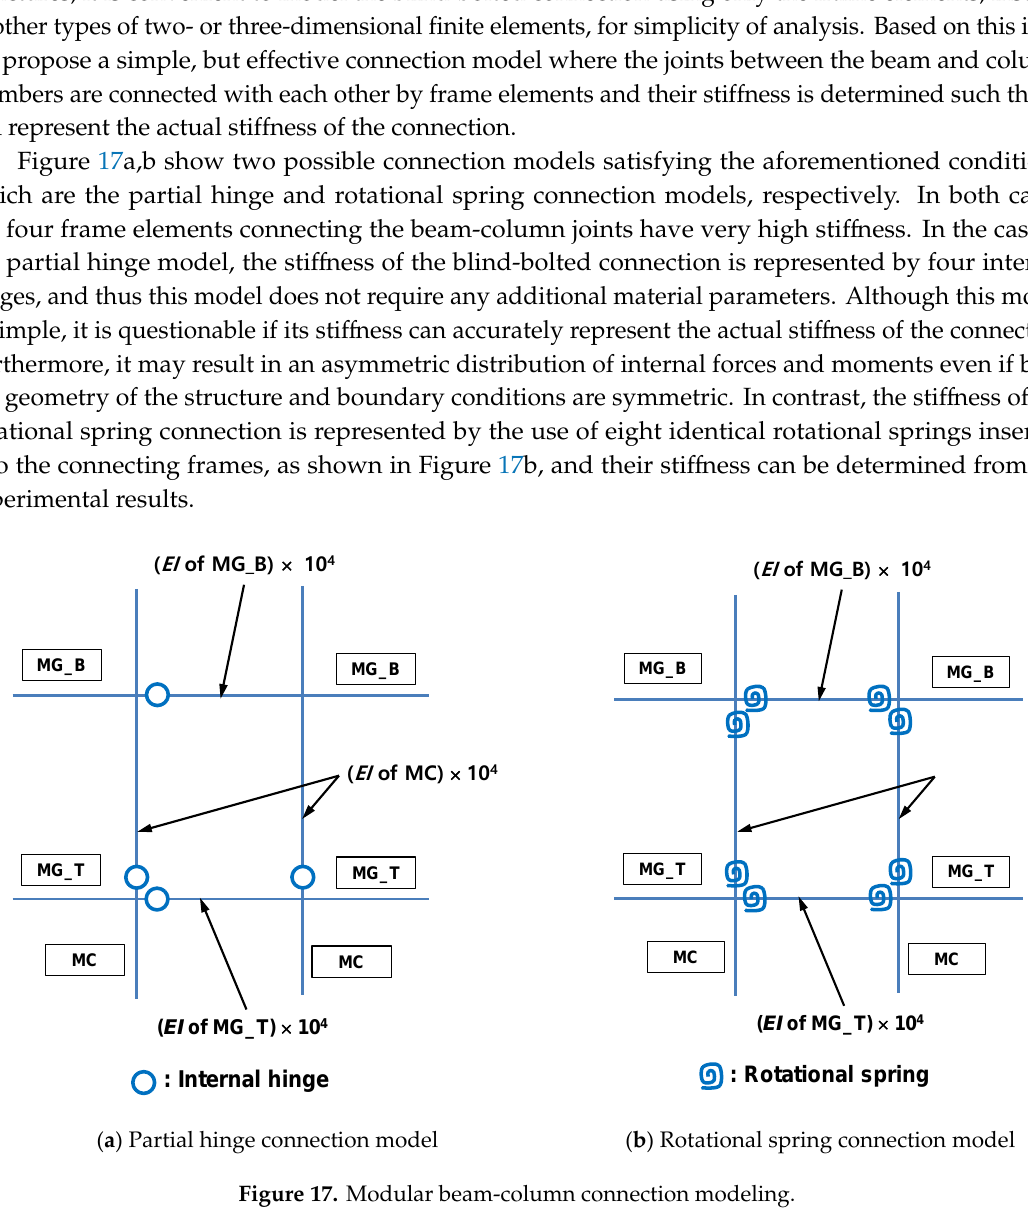
Figure 17. Modular beam-column connection modeling.